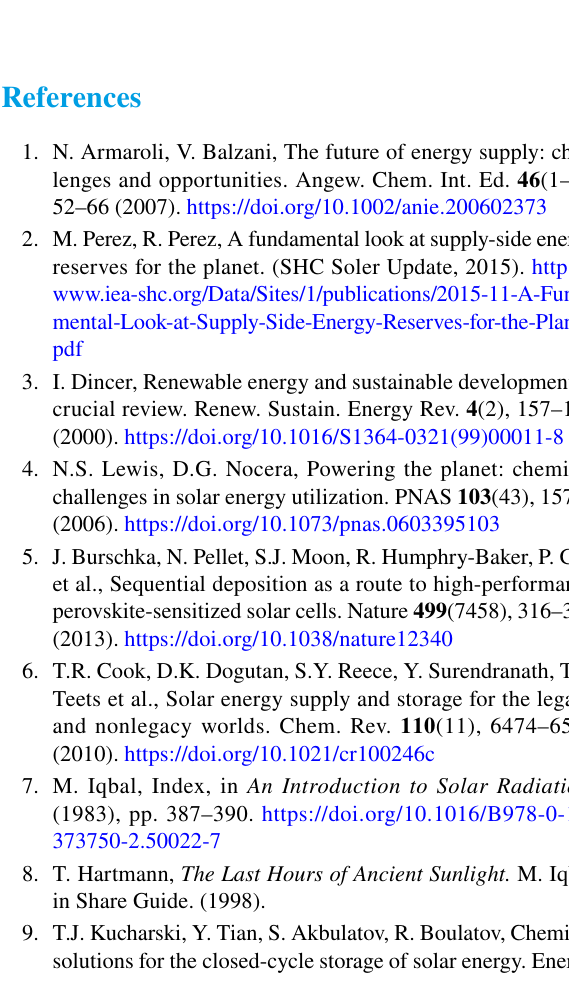
Fig. 22 Current challenges and future prospects of